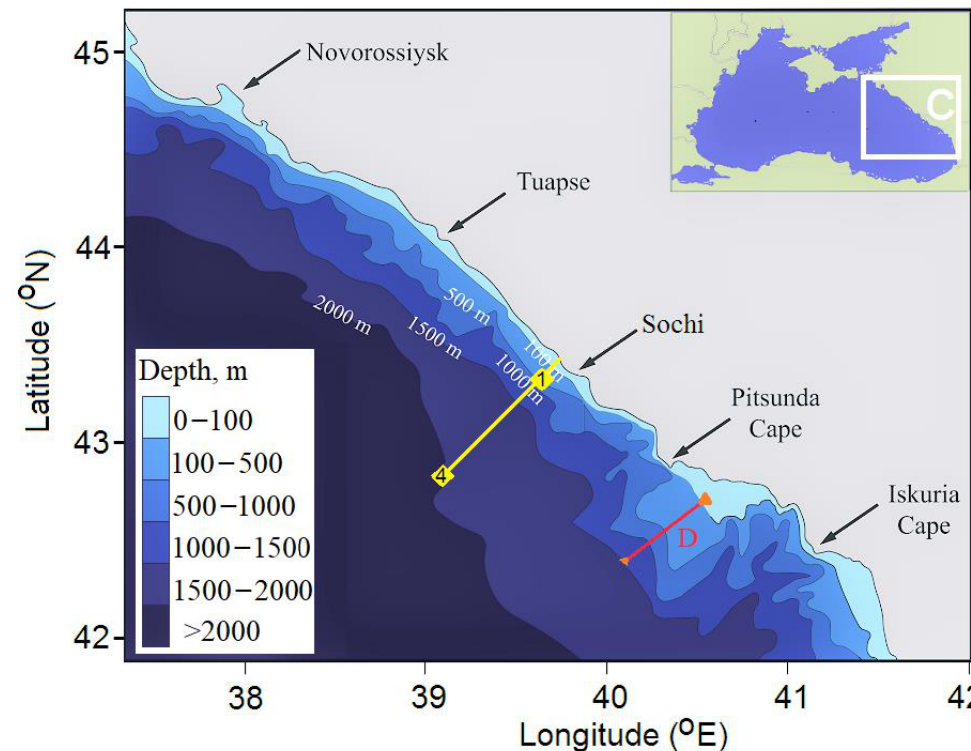
Figure 1. Bathymetry of the study area in the northeastern part of the Black Sea. Yellow line indicates section northwest from Sochi; yellow numbers 1 and 4 indicate sites at the shelf and continental slopes, respectively, which are referred to in Section 3. The red line D denotes the characteristic horizontal dimension of the submarine ridge used in Section 3.1 for estimation of shedding frequency.